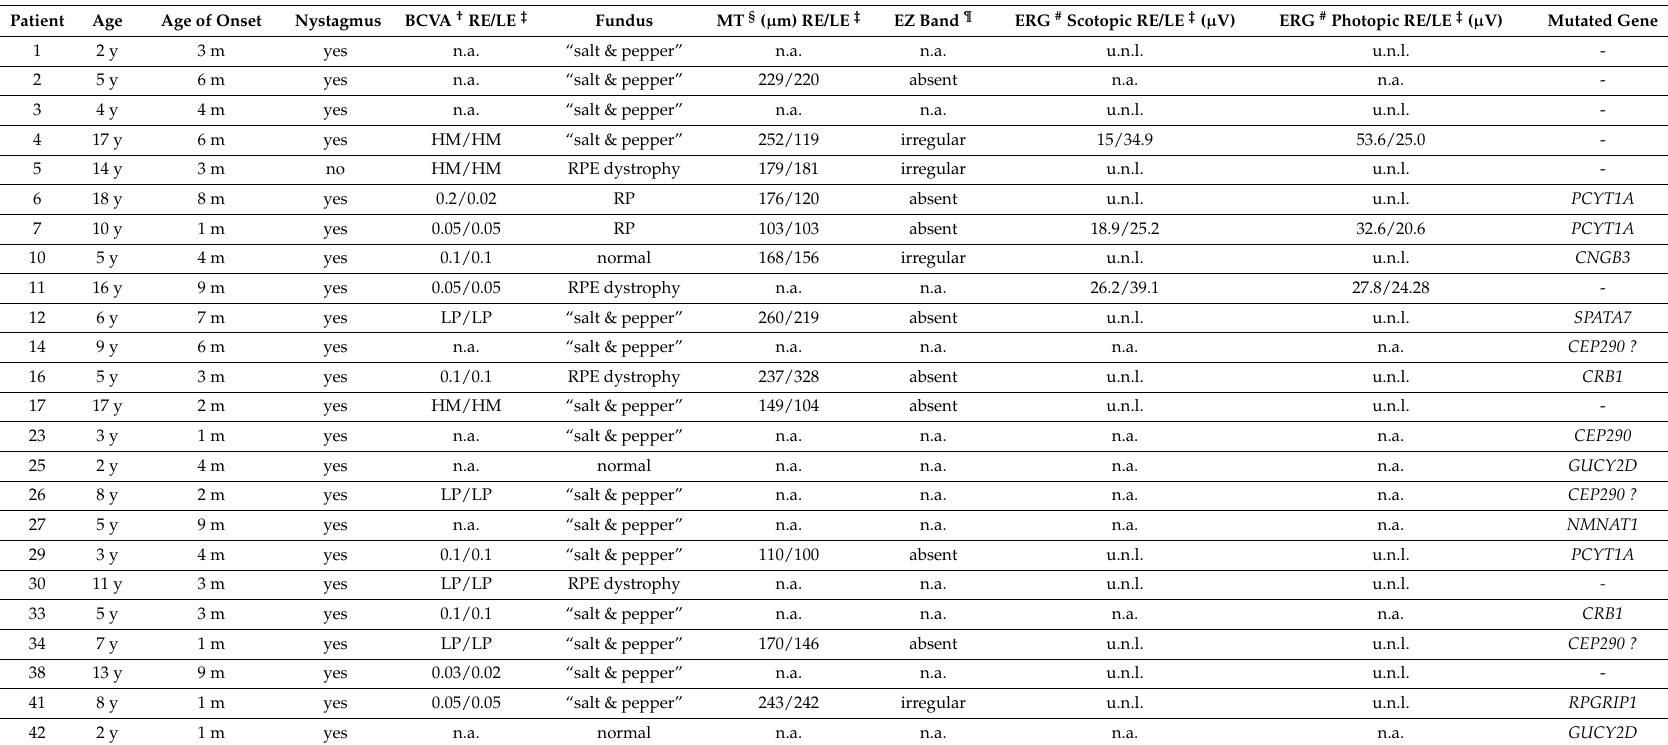
Table 2. Clinical and molecular data of Leber congenital amaurosis